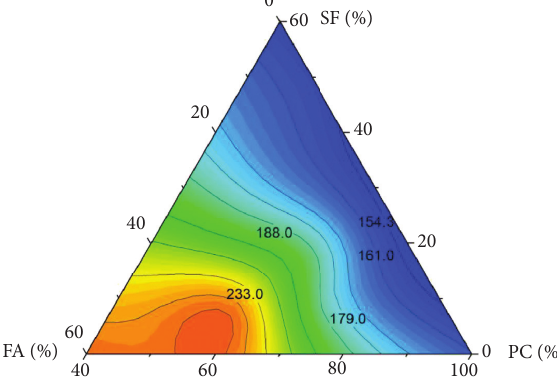
Figure 1: Effects of different cementitious composition on the flowability of